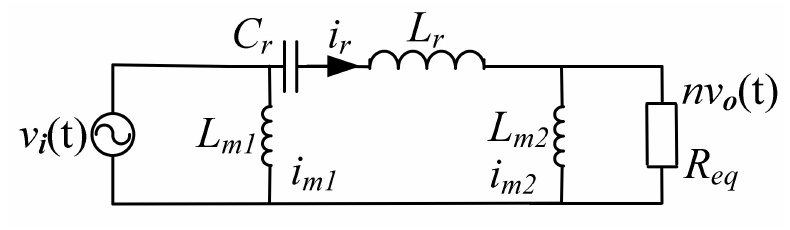
Figure 5. AC equivalent circuit of bidirectional LLC resonant